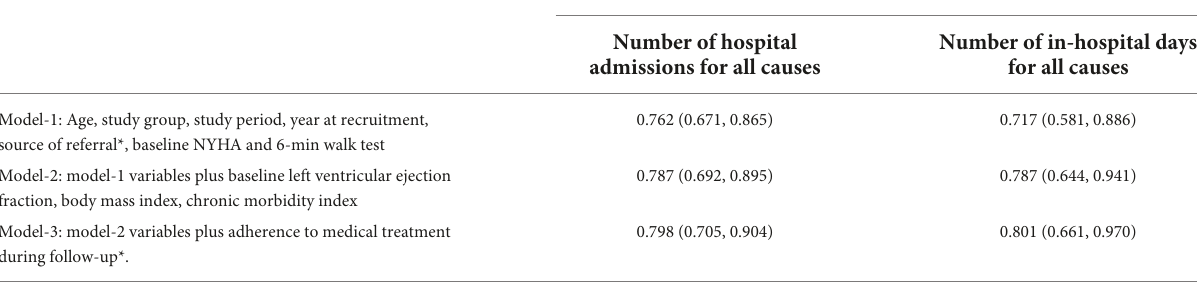
TABLE 3 Effect of sex on the number of hospital admissions for all causes during follow-up. Variables adjusted for in the model Adjusted rate ratio (95% confidence interval)